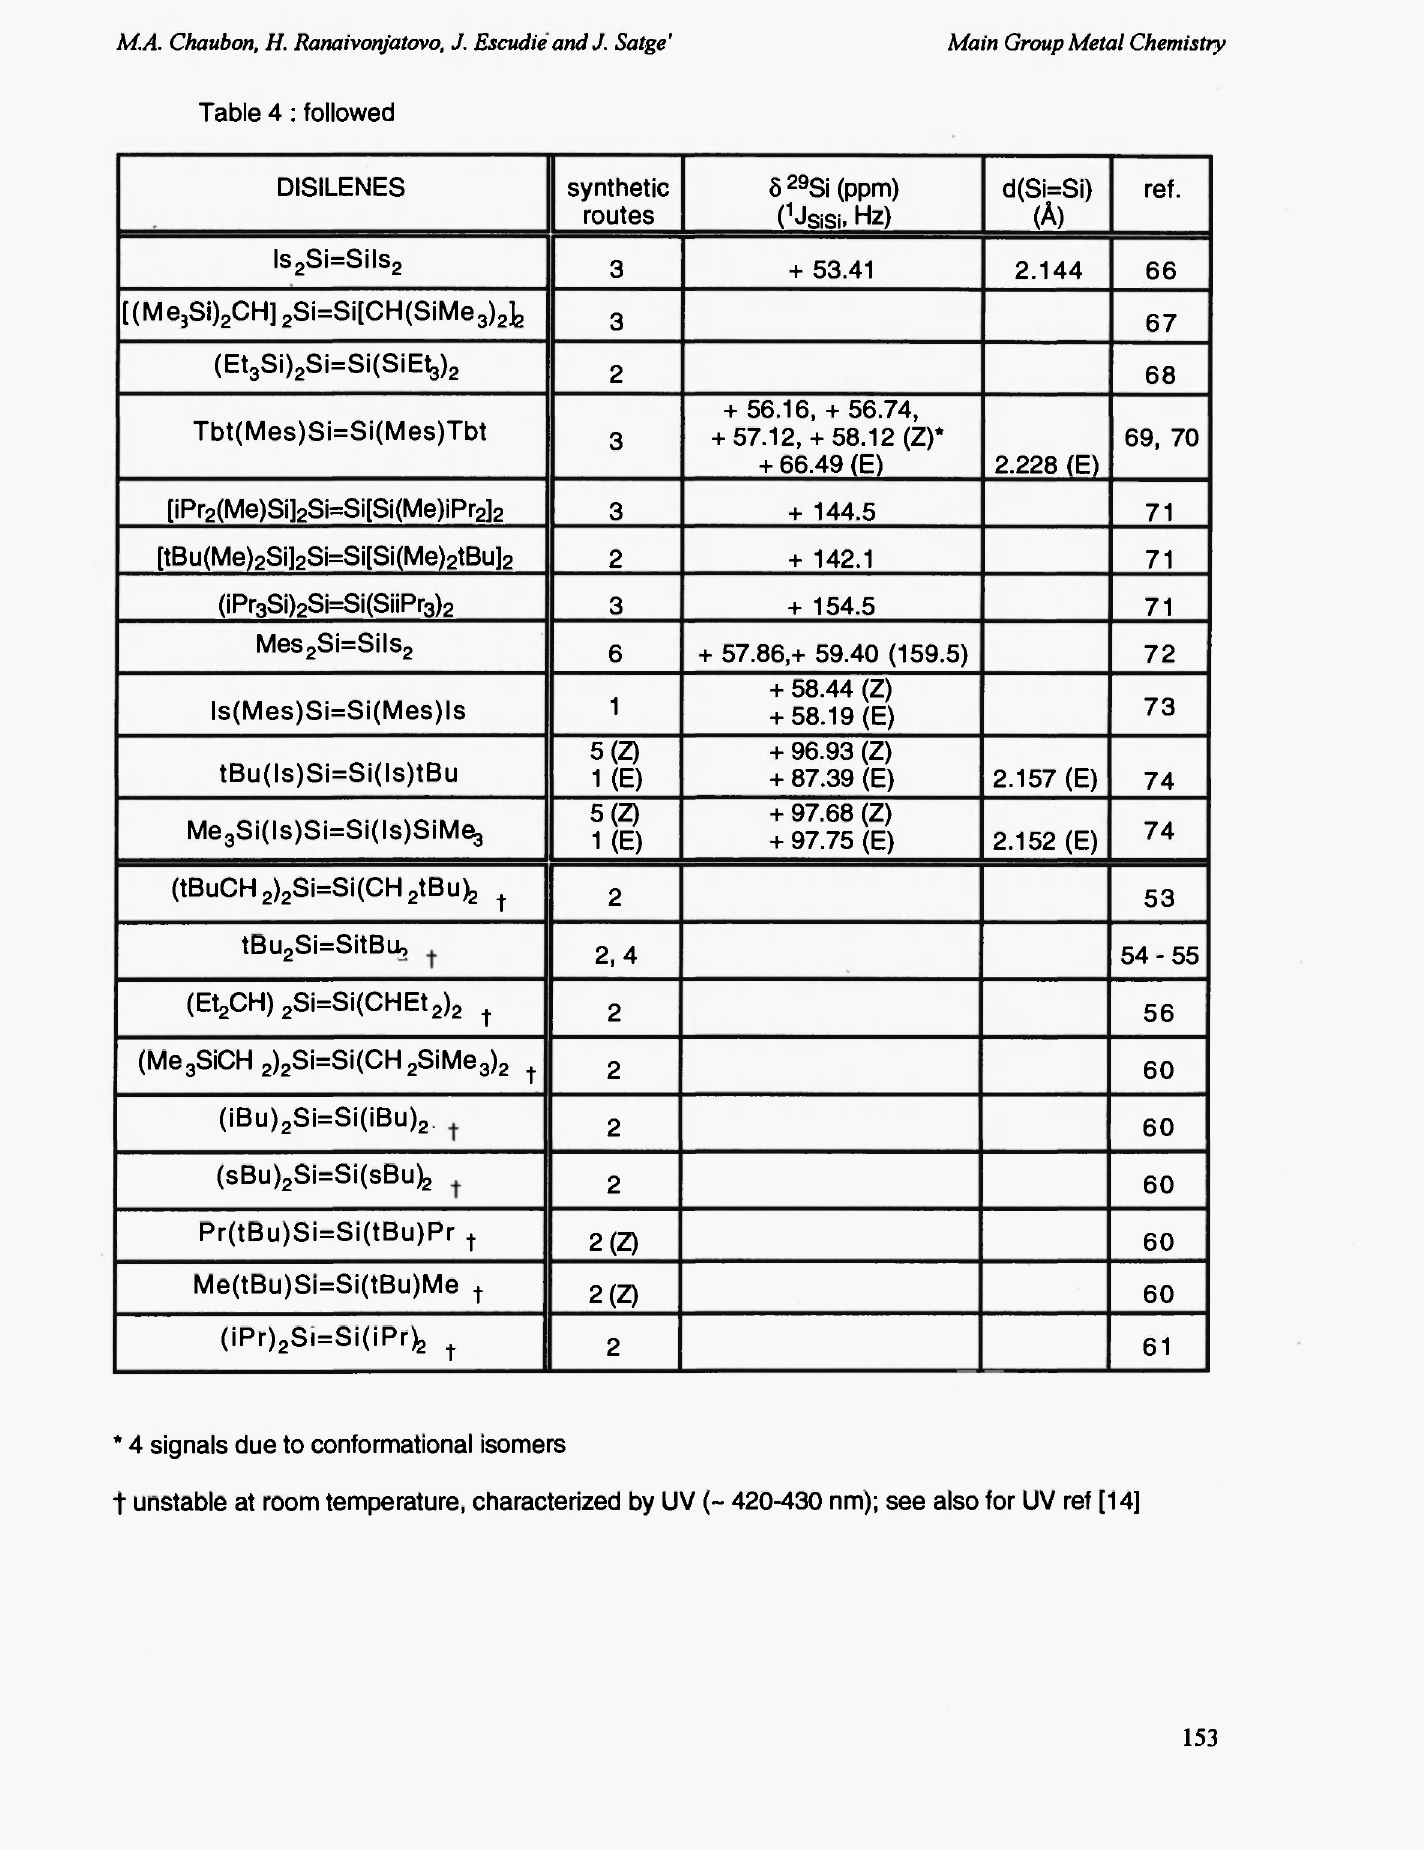
Table 4: followed DISILENES synthetic